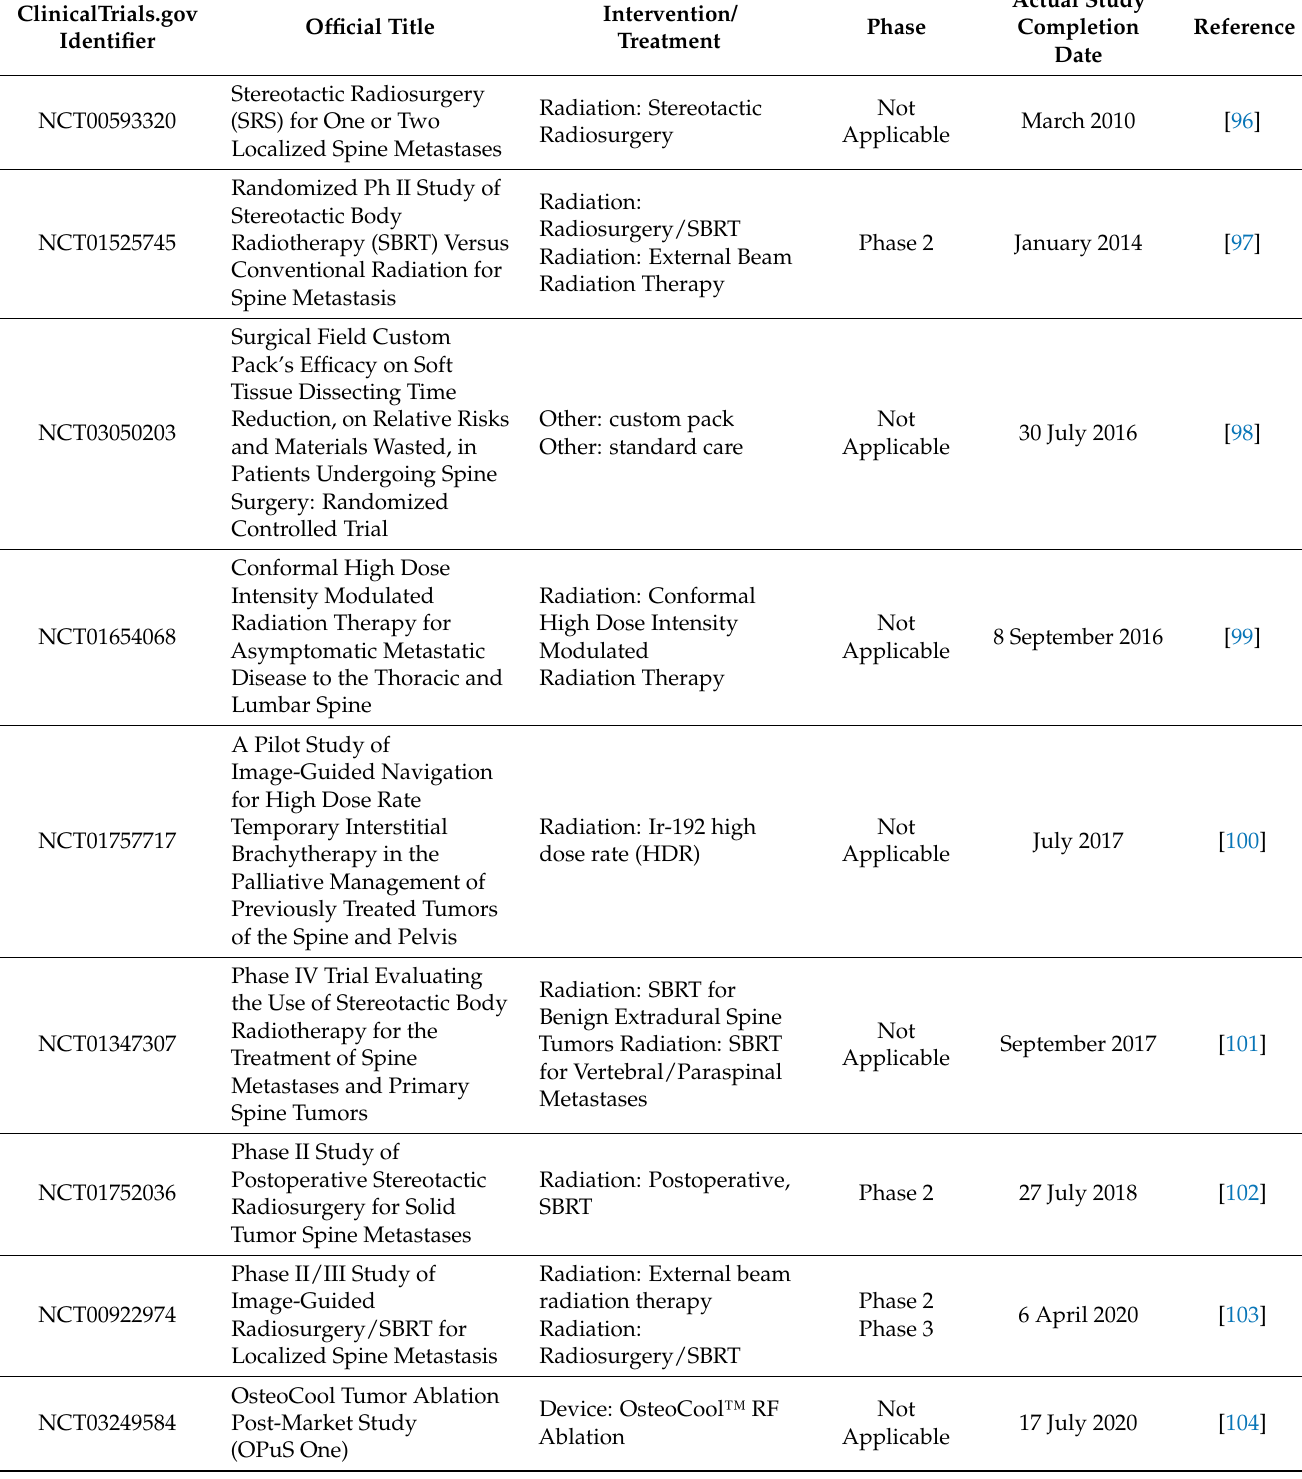
Table 3. Summary of completed clinical studies concerning spine tumors. Information retrieved from ClinicalTrials.gov using the following search constraints: “Spine tumor”—with results.